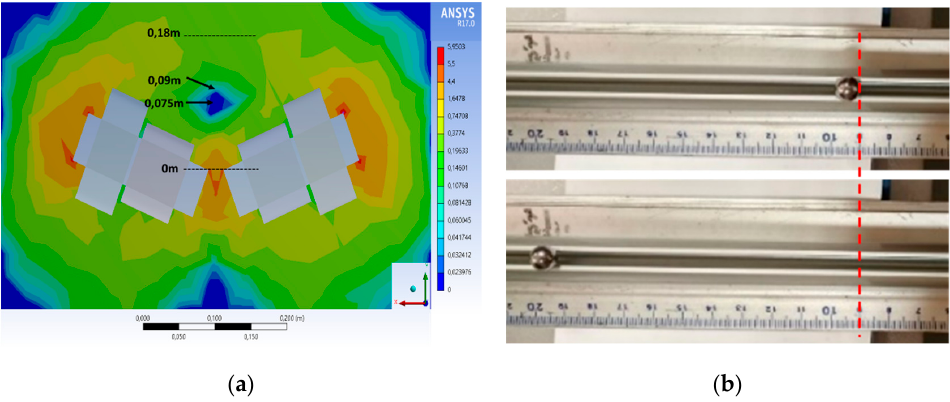
Figure 3. ( a ) Map of magnetic forces generated around the electromagnets; units reported in the simulation are arbitrary and are intended to highlight areas where the force is almost zero (dark blue), while the other colors indicate forces >0. The scale bar is in meters. ( b ) A paramagnetic sphere pushed from 9 to 19 cm on an aluminum rail using the actuator system.